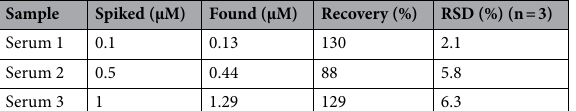
Table 1. Detection of dopamine in serum samples.